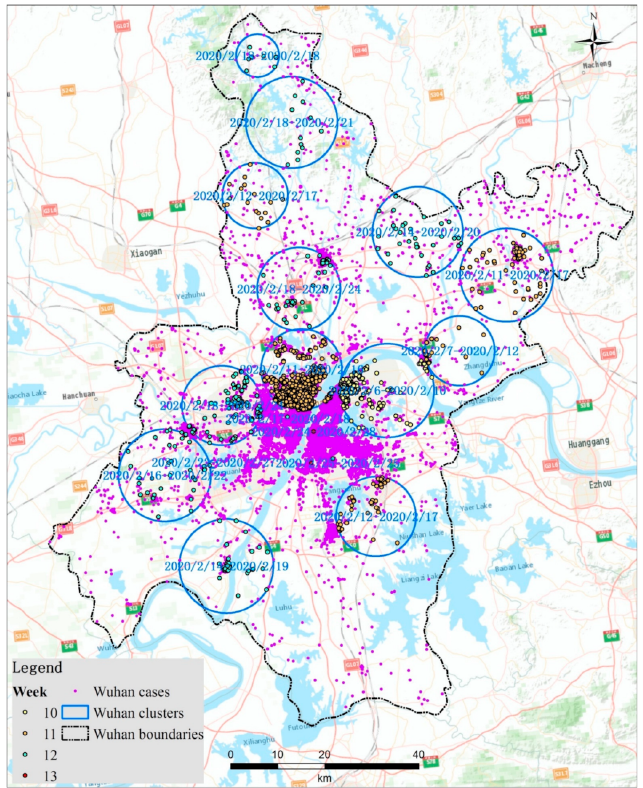
Figure 5. Zoomed space-time clusters of COVID-19 at the family-level with a maximum spatial scanning window size of 10 km in Wuhancity from 2 December 2019 to 20 June 2020.